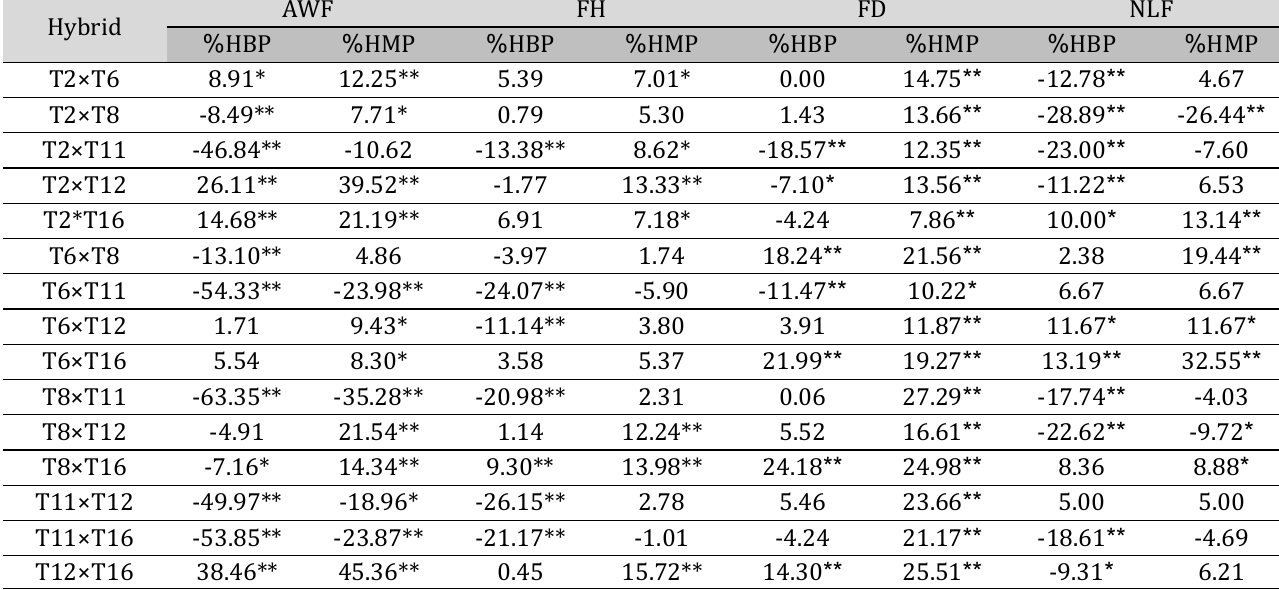
Table 5. Heterosis (%) for the hybrids compared to the mid-parents (HMP) and the best-parent (HBP) for the traits: average fruit weight (AWF), fruit height (FH), fruit diameter (FD), and the number of locales per fruit